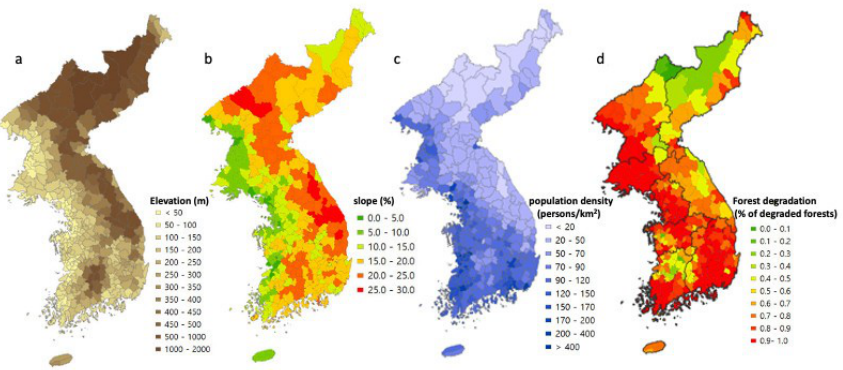
Figure 4. By district, as of 1910: ( a ) average elevation, ( b ) average slope, ( c ) population density/km 2 , and ( d ) deforestation rate (source: Bae and Kim, 2019).